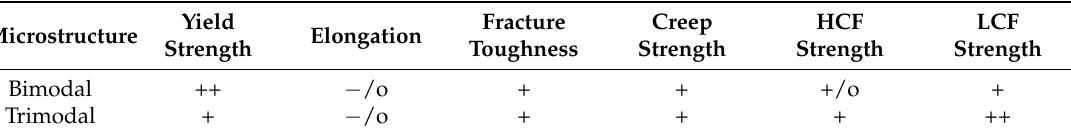
Table 1. The mechanical properties of different microstructures for TA15 titanium alloy (compared to equiaxed